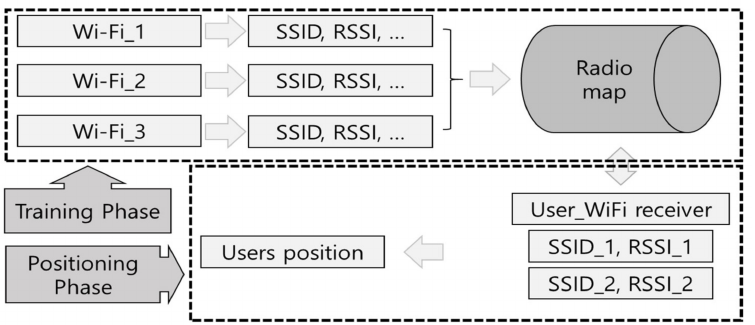
Figure 1. Typical fingerprint flow